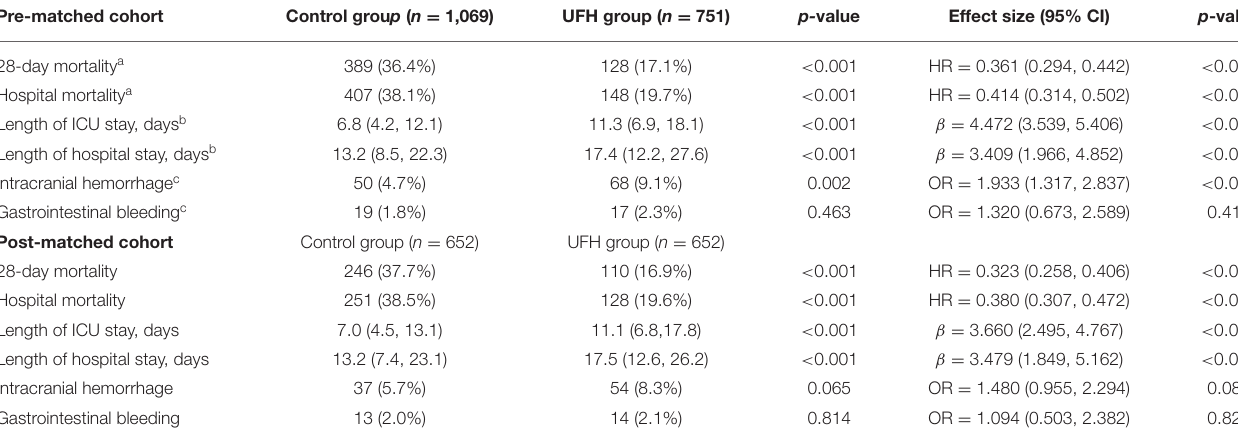
TABLE 2 | Association between UFH use and clinical outcomes in patients with sepsis- induced coagulopathy. Pre-matched